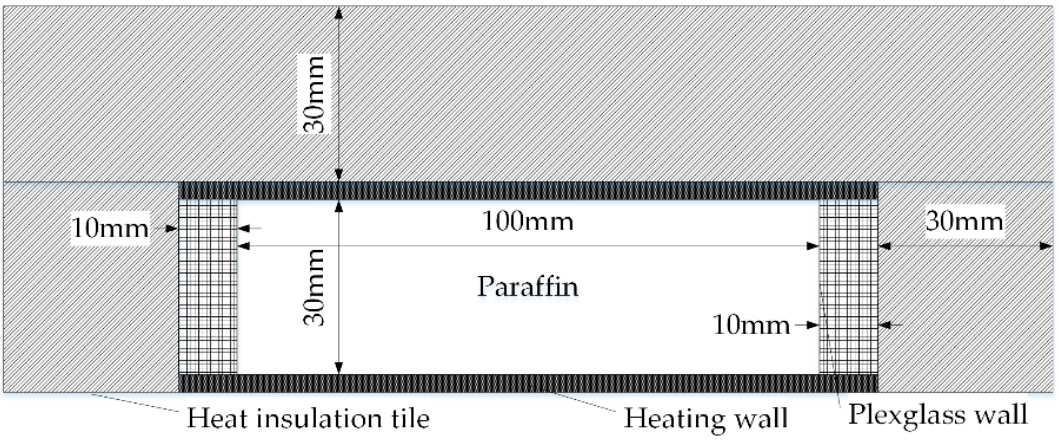
Figure 1. The structure of the specimen container.